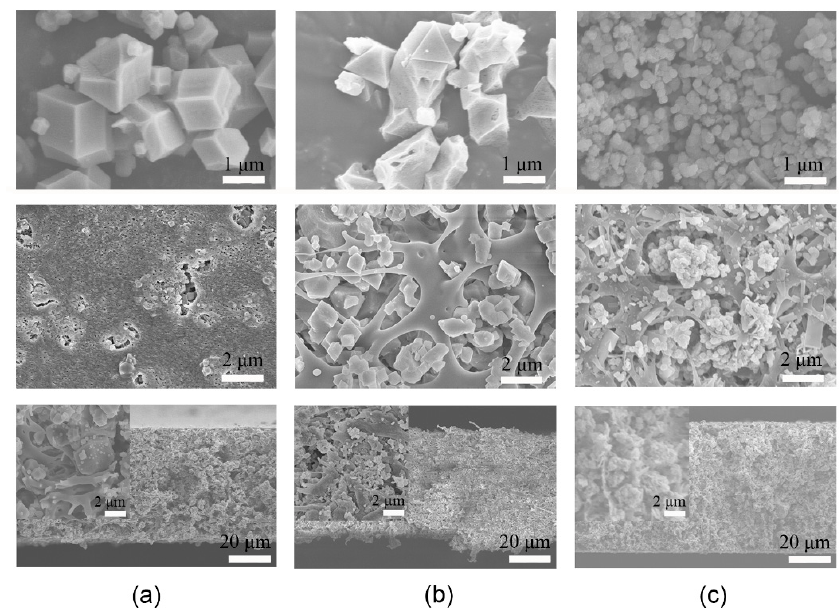
Figure 3. SEM images of ( a ) microsized ZIF-8 and ZIF-8/PES, ( b ) microsized HKUST-1 and HKUST-1/PES, and ( c ) microsized UiO-66 and UiO-66/PES. Top panels are the pure MOFs. Middle and bottom panels respectively correspond to the surface and cross-section of the membrane. Inset pictures show enlarged images. The solvent was DMF, and the loading of MOF was 60 wt.%.